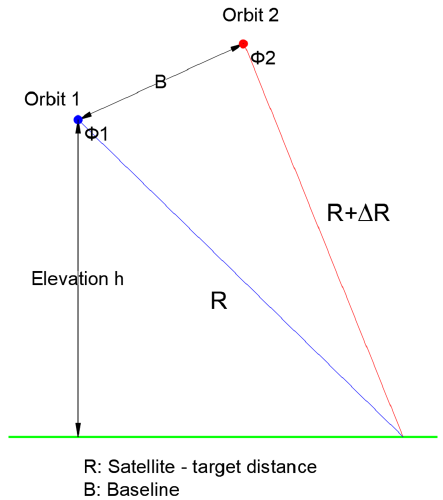
the electromagnetic signal and the distance travelled (R).